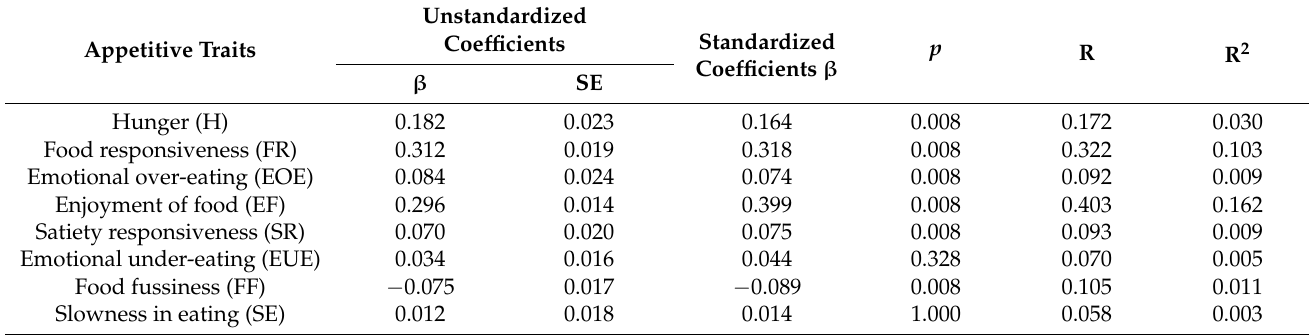
Table 9. Analysis of association between appetitive traits and snacks preference assessed by Food Preference Questionnaire (FPQ) (model adjusted for sex and age) within the population of the second phase of the Polish Adolescents’ COVID-19 Experience (PLACE-19) Study ( n = 2341).